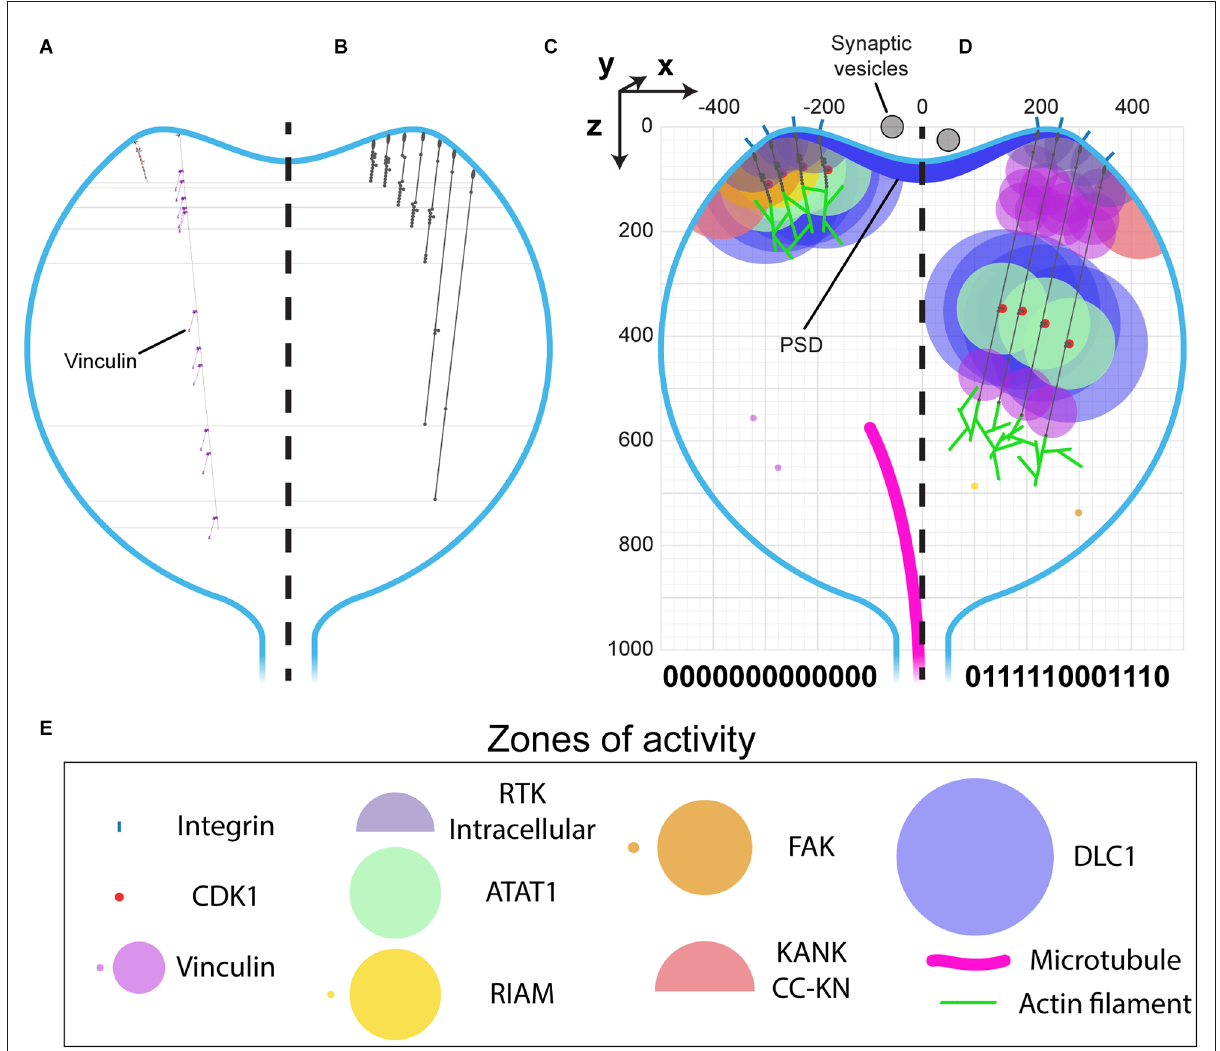
FIGURE6 MeshCODE to scale inside a dendritic spine indicates a mechanism for mechanical coordination of synaptic activity. (A–D) Scale drawings of a dendritic spine (1 µ m diameter), with talin in different switch states. (A) The talin extremes, the fully folded 0-state (left) is 86 nm and the fully extended 1-state (right) is 790 nm. The spatial positioning of the 11 VBS is shown with 11 vinculin molecules (purple) engaged. (B) Different talin states define layers in the z-dimension where binding sites are positioned. Molecules engaging talin will be spatially positioned between 0 and 700 nm from the integrin attachment site depending on the switch pattern. (C–E) Scale drawing of a spine showing the zones of activity of talin interacting molecules. A three-dimensional coordinate system is used, with the origin positioned at the centre of the active zone/PSD. This allows each molecule’s location to be defined with a Cartesian x, y, z coordinate, and distances between them described mathematically. The quantised steps in talin length move engaged spheres a precise distance in the direction of the force vector, which is a straight line away from the integrin attachment site around the active zone/PSD towards the spine neck. In this way the binary coding of the synapse will organise molecules at fixed positions relative to the origin. Four integrin-bound talin molecules are shown in (C) compact, and (D) extended states highlighting how the engaged molecules spatially resolve into layers as a function of the binary switch patterns. (E) Zones of activity of the molecules in (C,D) . Where two zones are shown, the smaller of the two represents the autoinhibited state and the larger the active